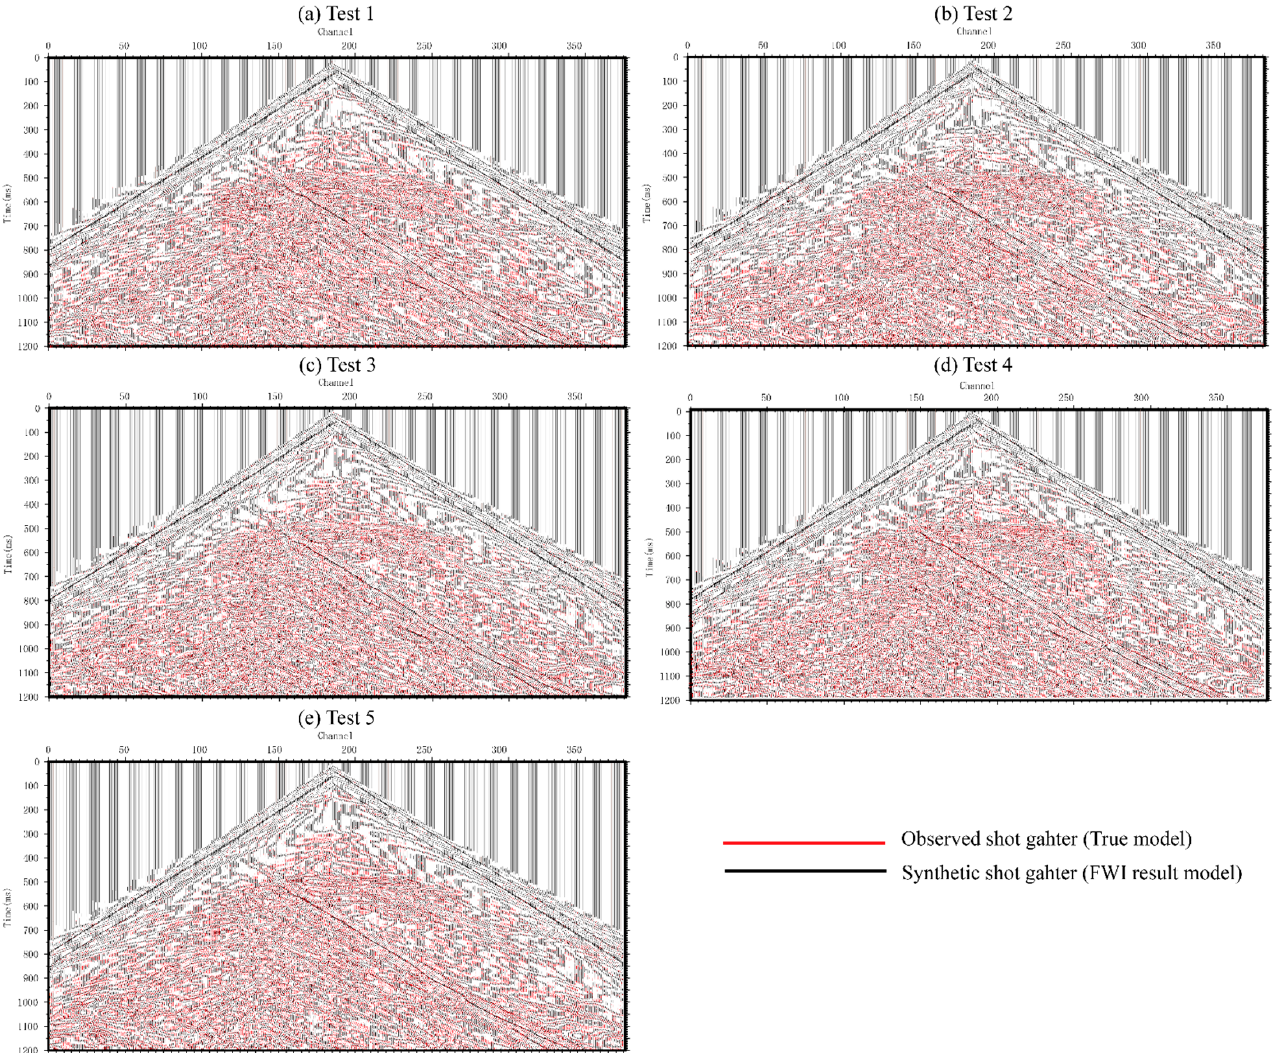
Figure 15. The comparison between the observed shot gather and synthetic shot gather from the different multisource FWI tests. The synthetic shot gather (black) is plotted on top of the observed shot gather (red); ( a – e ) are the comparison for tests 1–5.